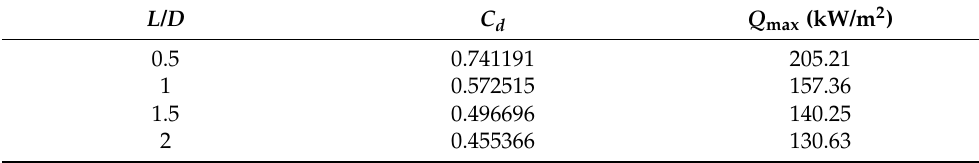
Figure 16. Initial pressure and heat flux of the forebodies with different lengths L : ( a ) pressure; ( b ) heat flux. Table 10. Comparison of the initial total drag coefficient and peak heat flux of the forebody.